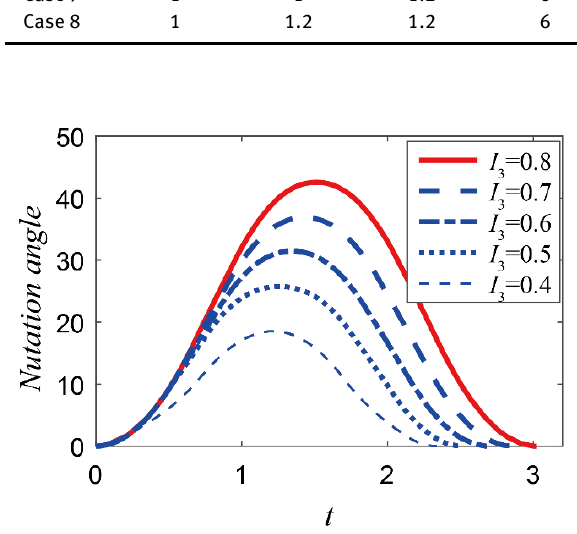
Figure 8. The nutation angle histories for the I3 varying from 0.8 to